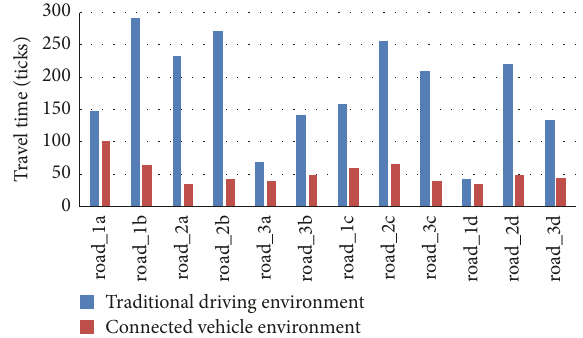
Figure 8: Maximum value of travel time under the traditional driving